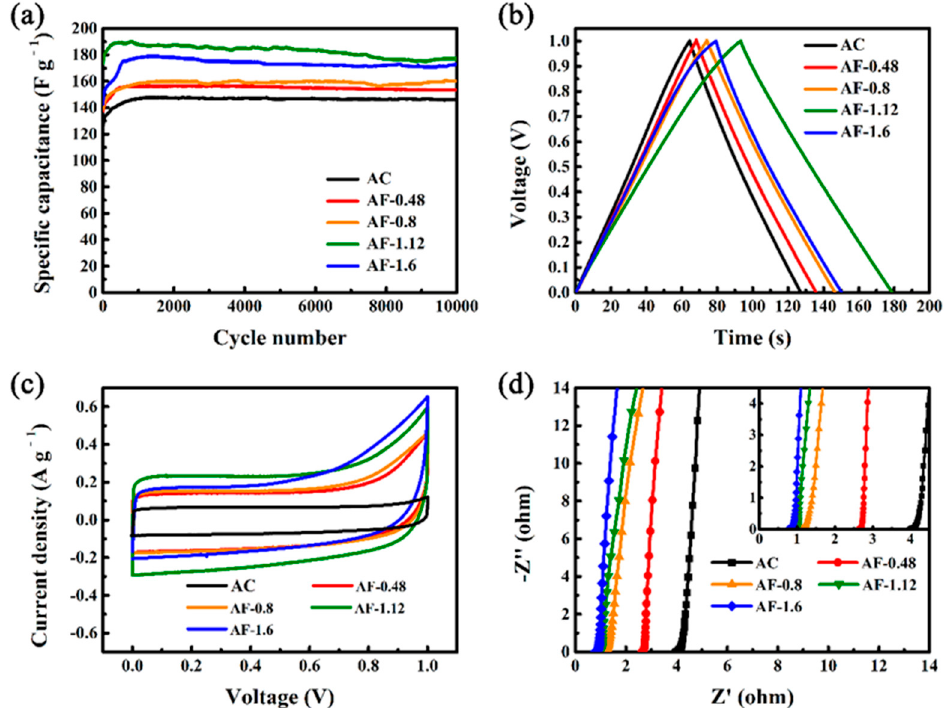
Figure 4. Cycle performances ( a ); galvanostatic charge/discharge (GCD) curves ( b ) at 1 A g − 1 ; CV curves ( c ) at 1 mV/s, and Nyquist plots ( d ) of AC and Fe@C composite supercapacitor (SC)